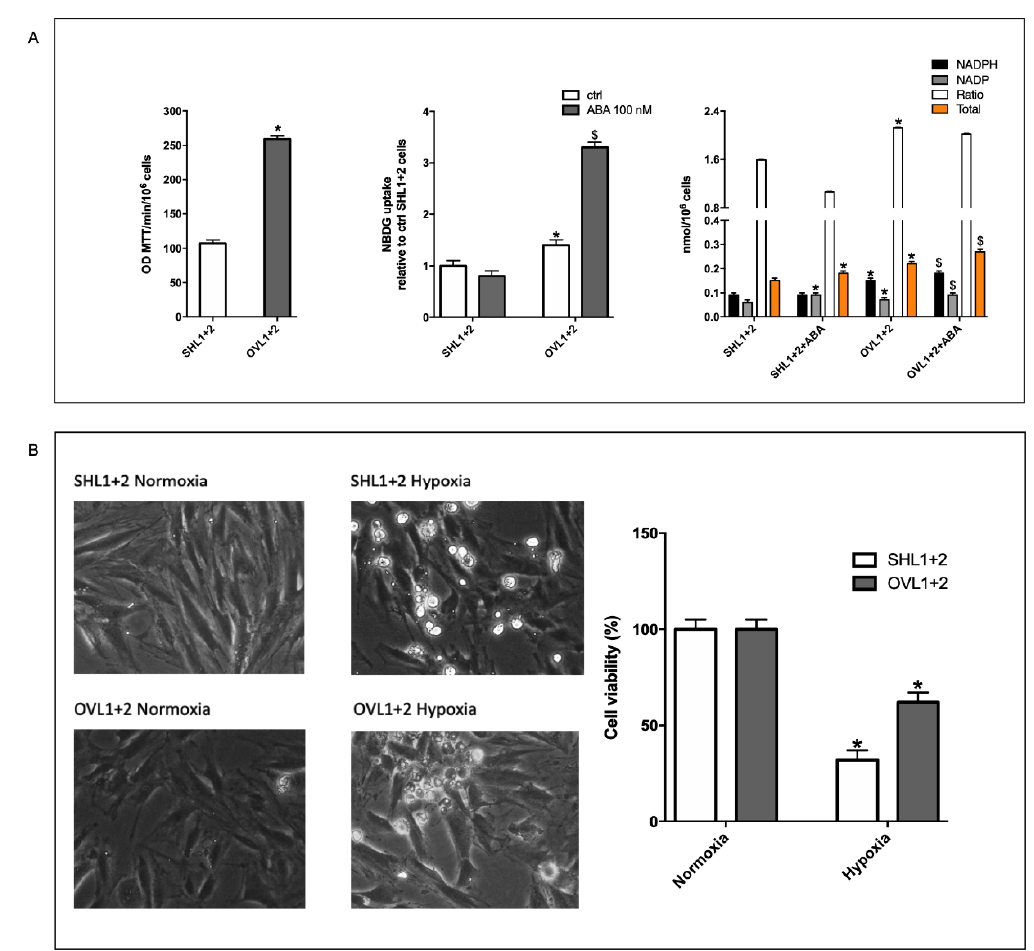
Figure 6. Increased oxidative metabolism and vitality of LANCL1/2-overexpressing vs. -silenced H9c2 under hypoxia. H9c2 cardiomyocytes, overexpressing LANCL1 and LANCL2 (OVL1+2) or double-silenced (SHL1+2) were cultured under normoxia or hypoxia as described in Materials and Methods; oxidative metabolism was explored by the reduction of MTT and the NADPH content ( A ), and cell vitality was evaluated by Trypan blue exclusion ( B ). ( A ) Left panel, after 18 h incubation in complete DMEM in normoxia at 37 °C, cells were washed in PBS buffer and incubated with MTT (0.5 mg/mL) for 1 h at 37 °C. The insoluble formazan crystals were dissolved in 100 µL DMSO, and the absorbance was quantified at 570 nm. Results are expressed as optical density units (OD)/min incubation/10 6 cells seeded at time zero and are the mean ± SD from at least three experiments. * p < 0.01 relative to LANCL1/2-silenced cells by unpaired t -test. Central panel, 2-NBDG uptake under normoxia of LANCL1/2-silenced or -overexpressing cells, pretreated or not with 100 nM ABA before the addition of 2-NBDG. Results are expressed relative to the fluorescence of ABA-untreated, double-silenced cells and are the mean ± SD from at least three experiments. * p < 0.01 relative to untreated control cells and $ p < 0.05 relative to ABA-treated control cells by unpaired t-test. Right panel, NADP and NADPH content in cells incubated in complete DMEM without (control) or with 100 nM ABA for 18 h under normoxia at 37 °C. Results are the mean ± SD from at least three experiments. * p < 0.01 relative to untreated control cells and $ p < 0.05 relative to ABA-treated control cells by unpaired t-test. ( B ) Left panel, representative phase contrast microscopic images of cells. Right panel, cell vitality as determined by Trypan blue exclusion after 18 h hypoxia and 1 h reoxygenation; at least 100 cells per condition were examined. Results are the mean ± SD of three separate experiments. * p < 0.01 relative to normoxia by unpaired t-test.